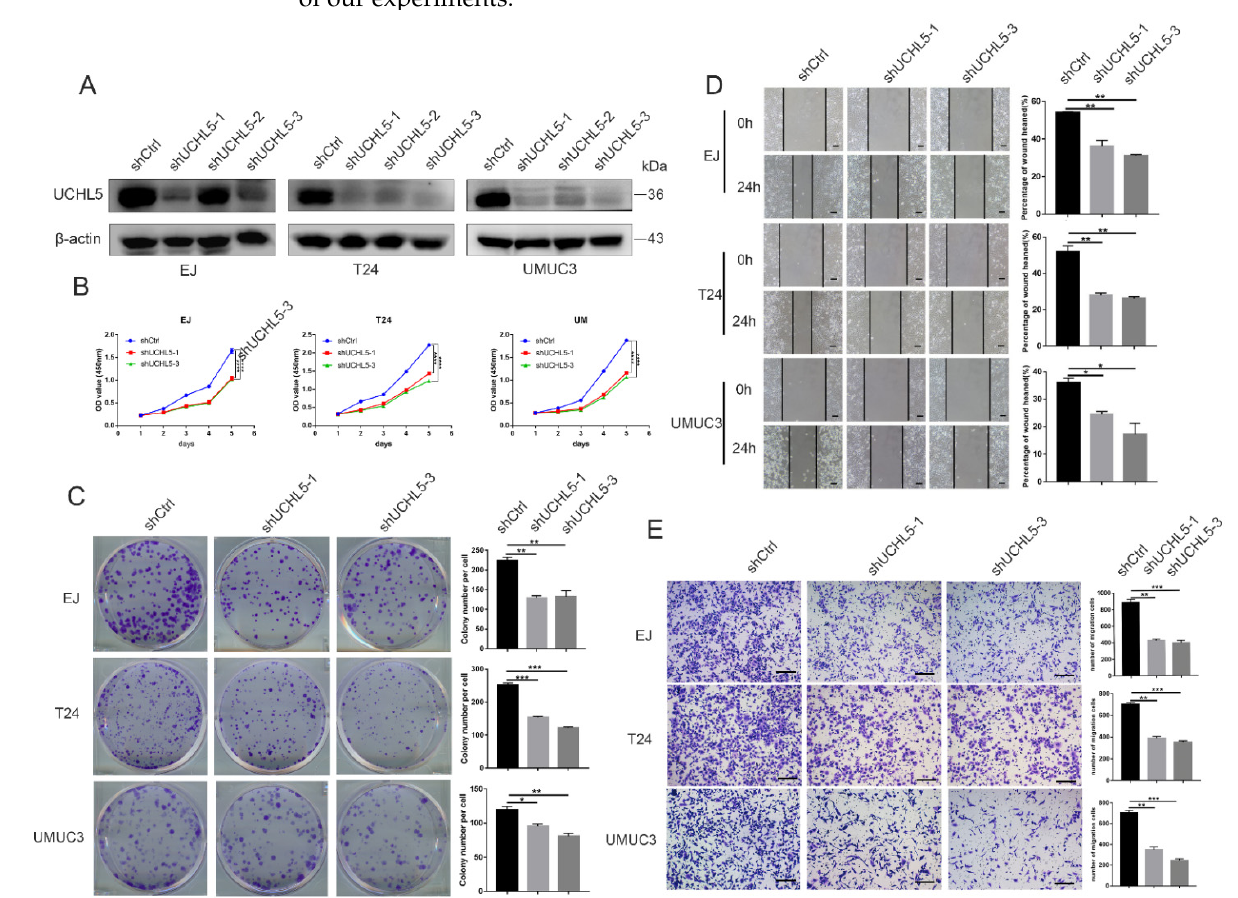
Figure 2. UCHL5 depletion represses tumor formation in vitro. ( A ) UCHL5 silencing in bladder cancer cells confirmed via Western blotting assays. β -Actin is used as the loading control. ( B ) The proliferation of cells between two UCHL5 silencing groups and control group at 24, 48, 72, 96, and 120 h by CCK-8 assay. ( C ) Colony formation assays. The number of clones was counted and plotted. ( D , E ) Migration ability evaluated using wound-healing (Scale bar = 100 µ m) and Transwell migration assay (Scale bar = 200 μ m). Values are shown as mean ± SD of three independent experiments. * p < 0.05, ** p < 0.01, *** p <0.001, and **** p < 0.0001 compared with controls.